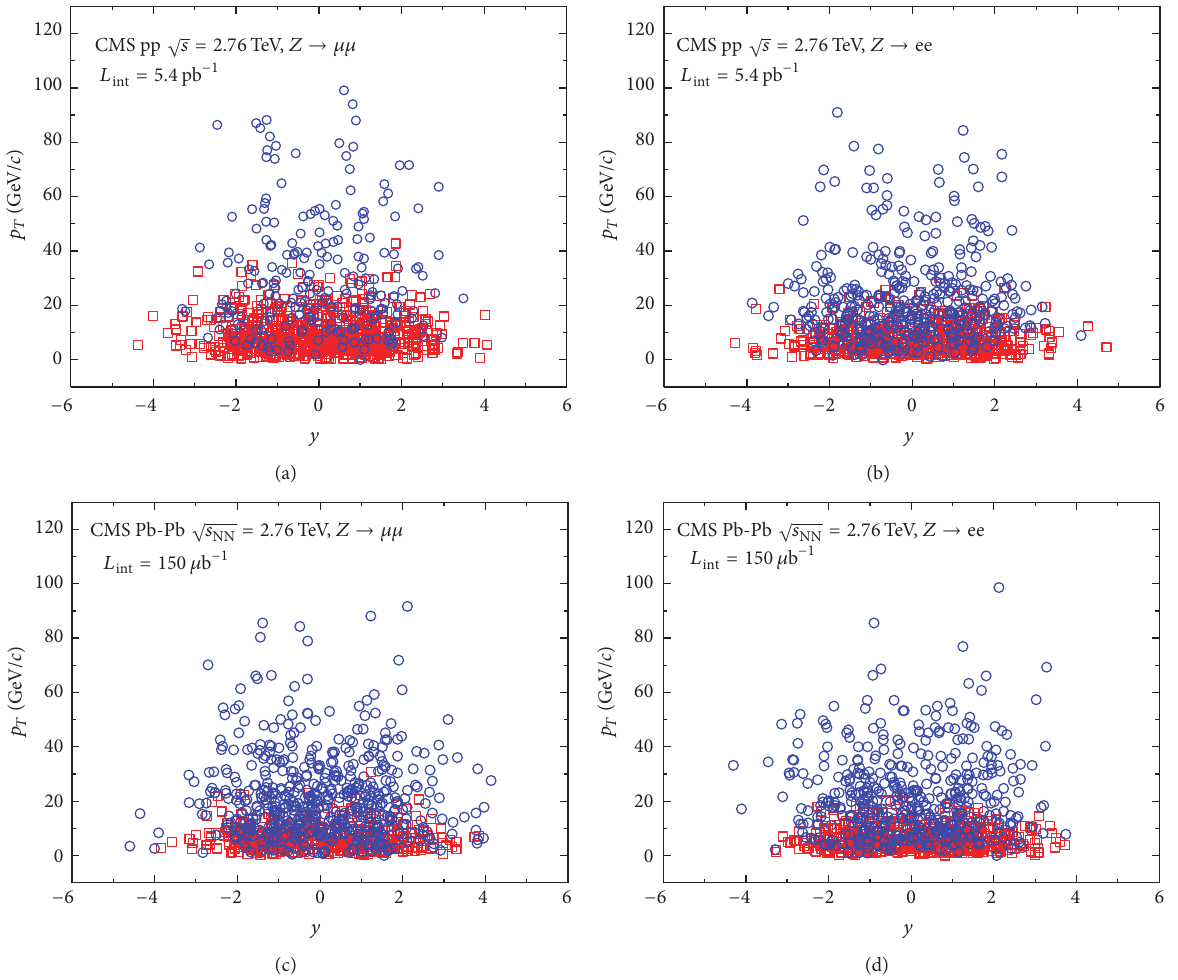
Figure 3: Event patterns (particle scatter plots) in two-dimensional 𝑝 𝑇 - 𝑦 space in (a)-(b) pp collisions at √𝑠 = 2.76 TeV and (c)-(d) Pb-Pb collisions at √𝑠 NN = 2.76 TeV, for the (a)-(c) dimuon and (b)-(d) dielectron decay channels. The number of 𝑍 bosons for each panel is 1000. The squares and circles represent the results of the first and second components in the two-component Erlang distribution for 𝑝 𝑇 , respectively. The contributions of the first and second components in the two-component Gaussian distribution for 𝑦 are not distinguished by design.